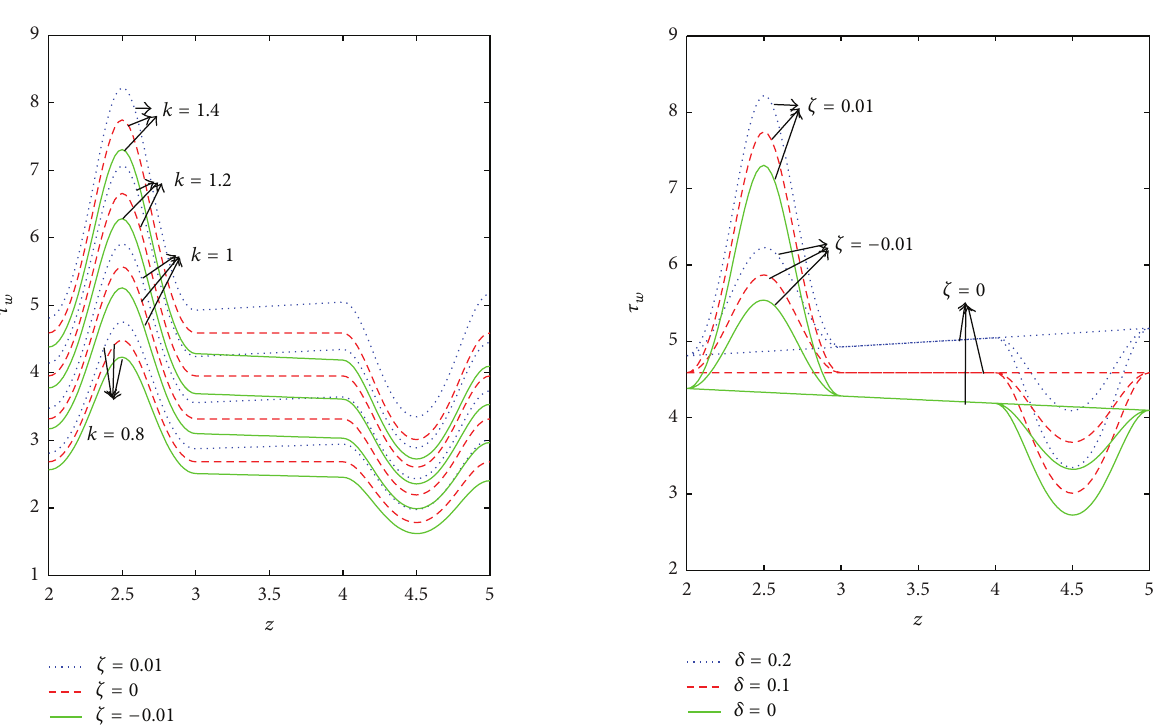
Figure 6: Axial variation of wall shear stress ( 𝜏 𝑤 ) for different values of consistency index ( 𝑘 ) taking 𝑛 = 0.8 and 𝜏 𝑦 = 0.1 .